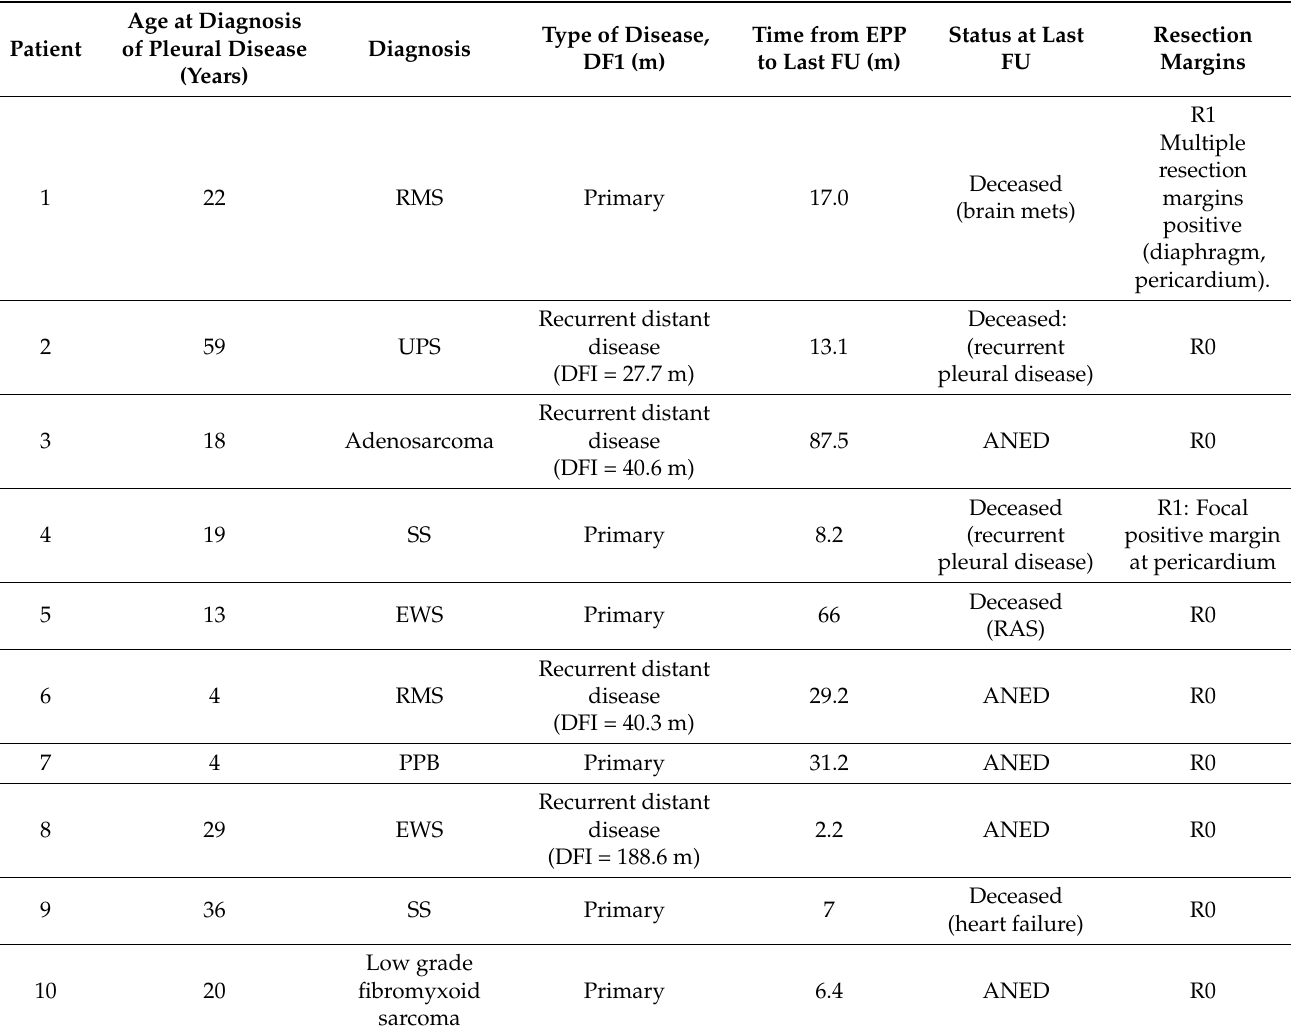
Table 1. Diagnosis and outcome of patients who underwent